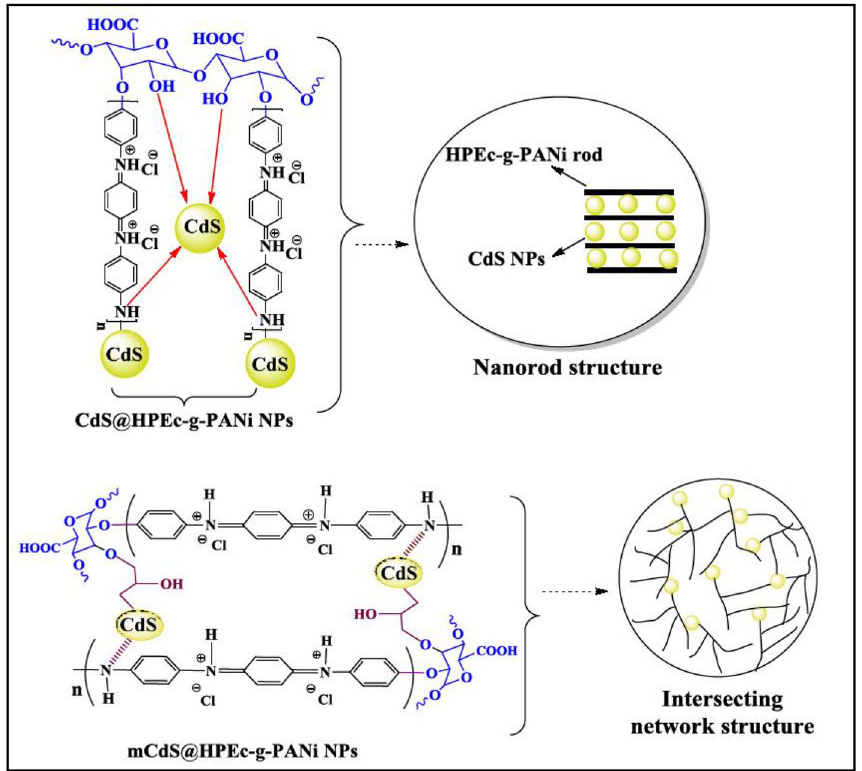
Figure 1. The schematic representation of the nanocomposites.